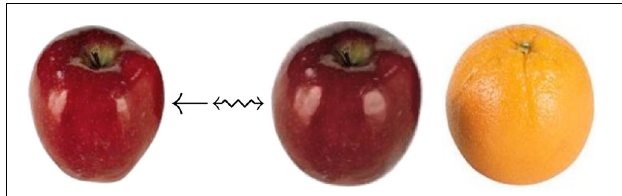
FIGURE 4 | This RGB image registration example employs ITK 4 code that repurposes a scalar metric ( itkMeanSquaresImageToImageMetr icv4 ) for multichannel